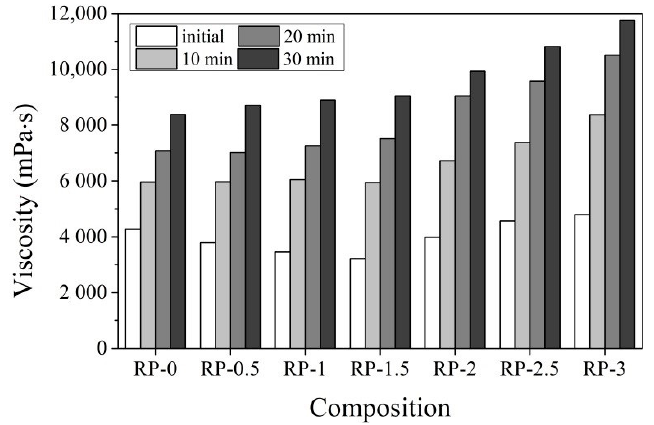
Figure 1. Viscosity of CEM IIR paste (LR) with different dosages of CN (0–3%) depending on time at +20 °C temperature (0—immediately after paste preparation; 10—after 10 min; 20—after 20 min; 30—after 30 min).